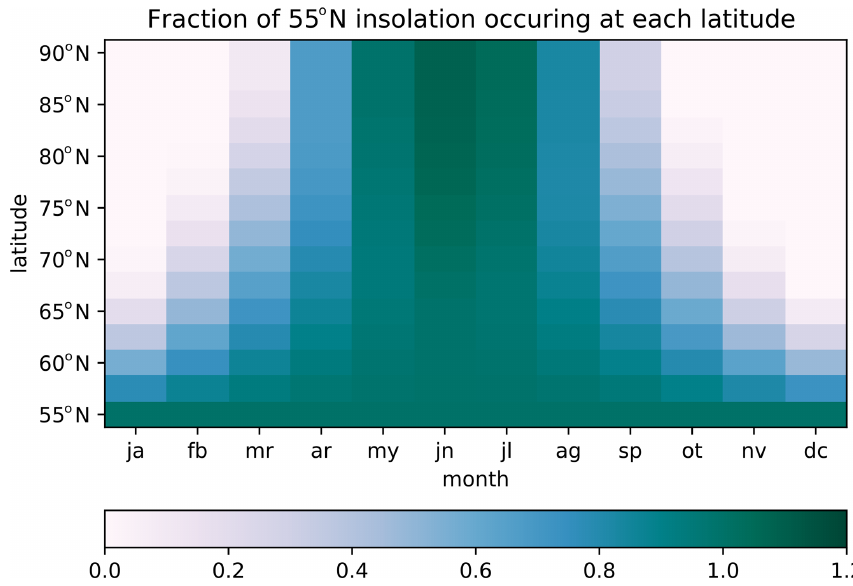
Figure 8. TOA insolation by latitude and month. This has been normalized by dividing the insolation for a latitude and month by the insolation for that month at 55 ◦